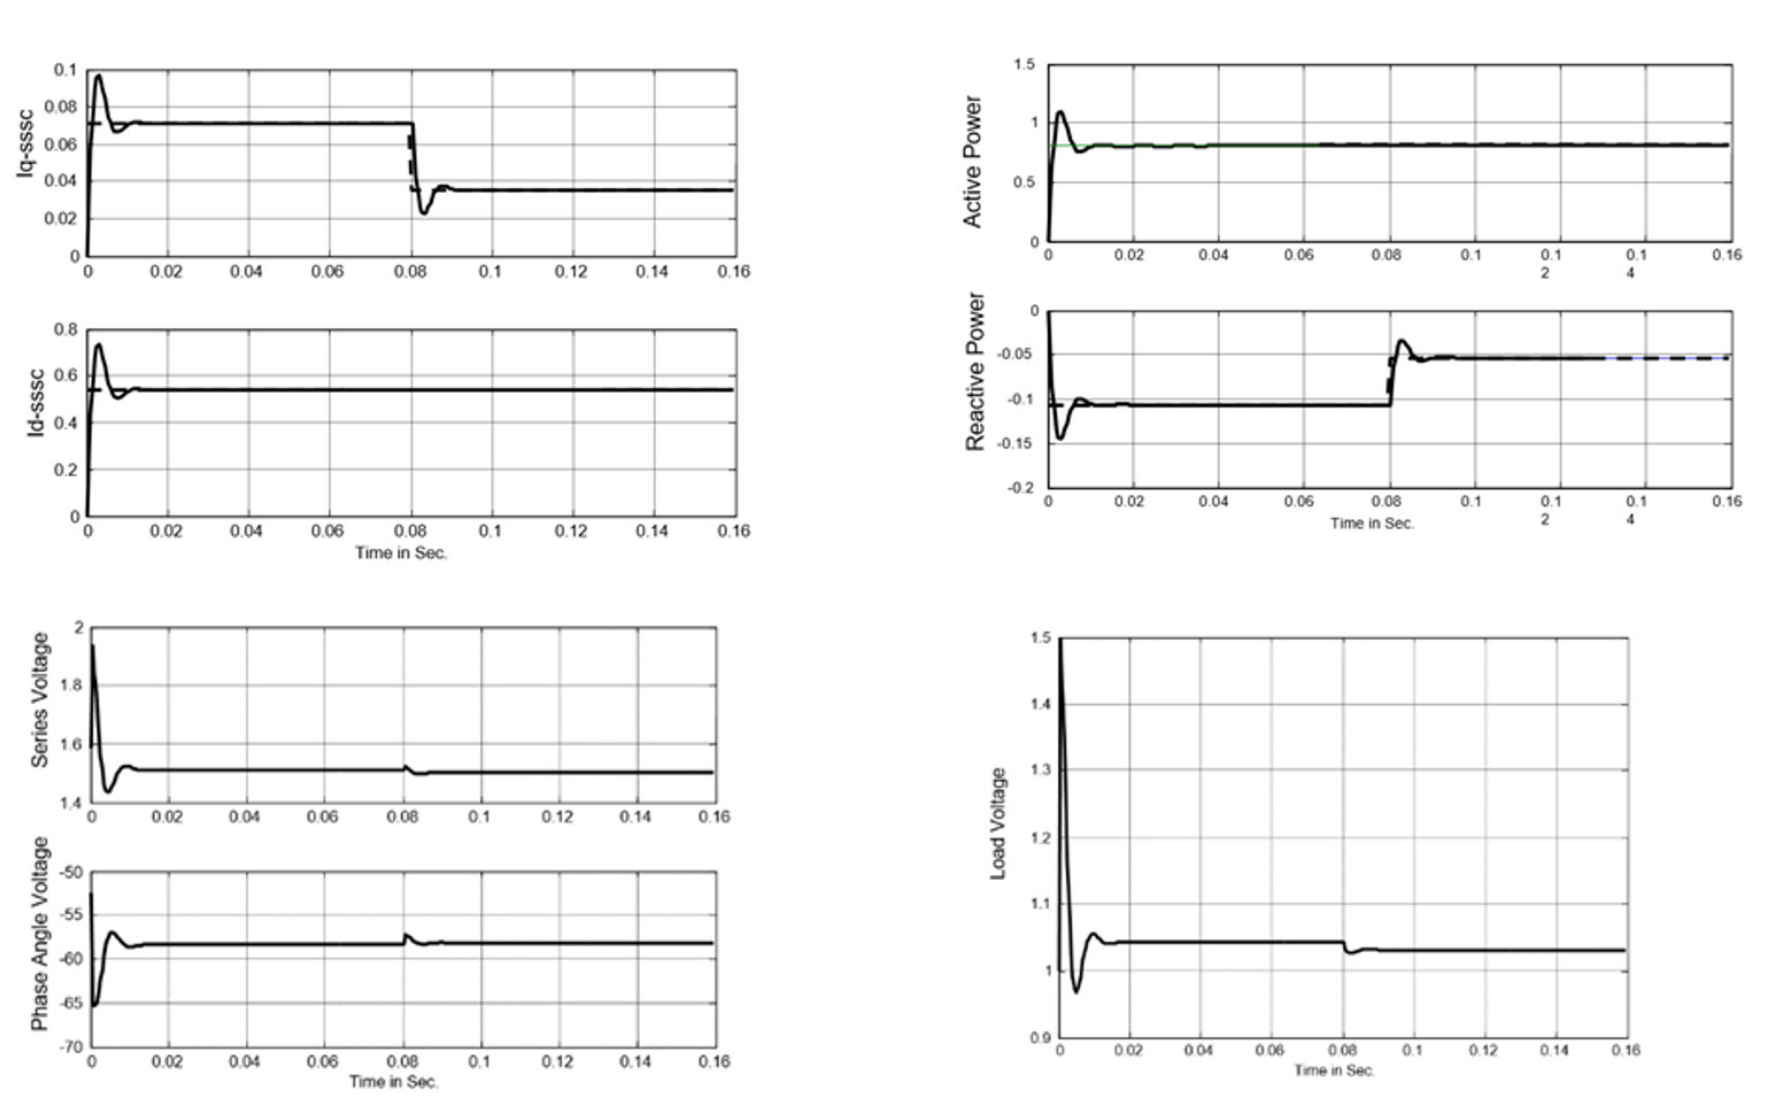
Figure 12. The transient performance of the SSSC in case of reactive power variation with